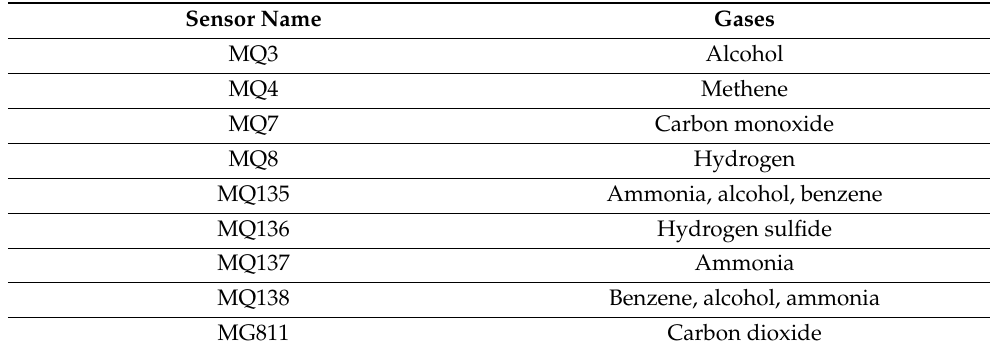
Table 2. Gas sensors integrated into the electronic nose and gases they are most